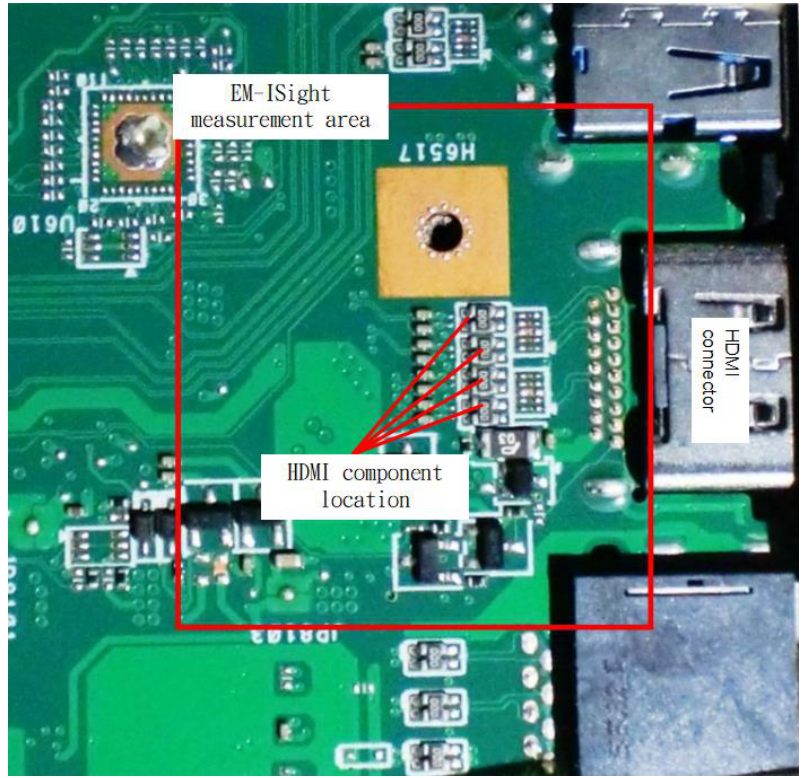
Figure 15. HDMI near field measurement area diagram of PCB initial version.